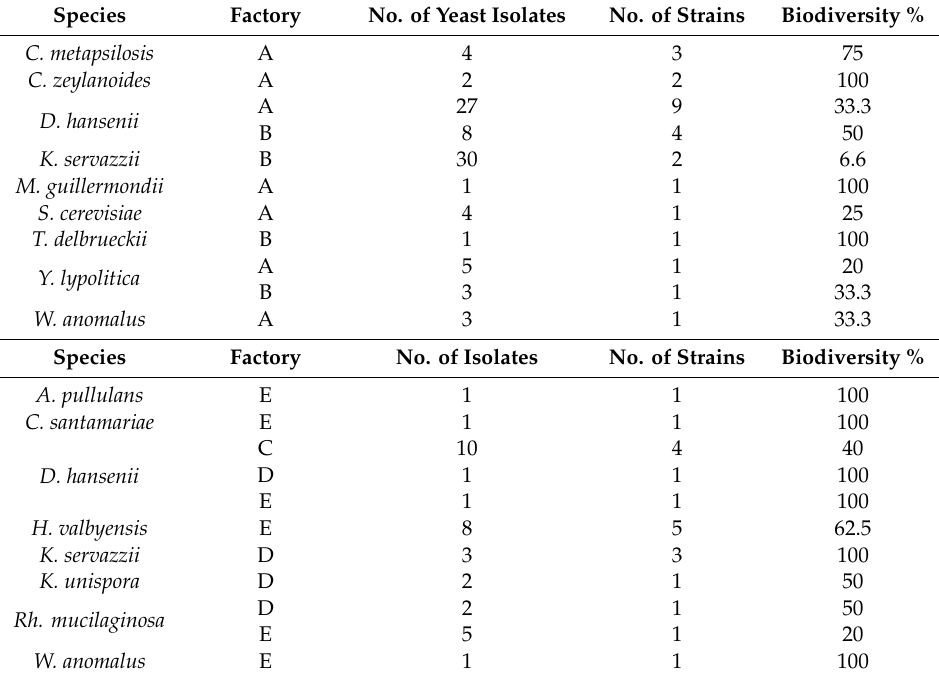
Table 2. Distribution of the isolates and strains found in pork (Factories A and B) and game (Factories C, D, and E) fermented